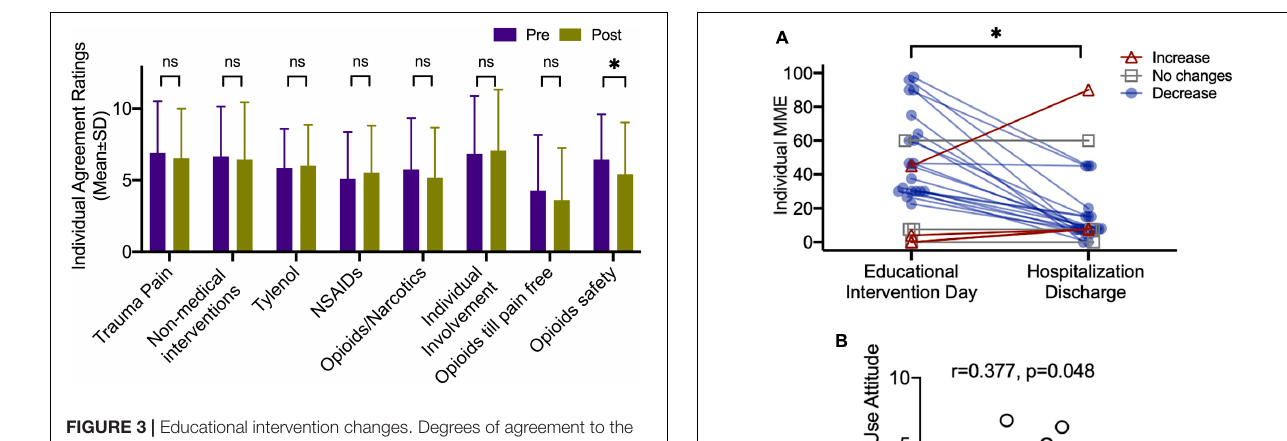
FIGURE 3 | Educational intervention changes. Degrees of agreement to the statements regarding the importance of pharmacological and non-pharmacological treatments for acute trauma pain. Opioids safety significantly changed with a decreased mean score of 6.92 (SEM = 0.60) at the pre-education phase as compared with 6.09 (SEM = 0.72) at the post-educational intervention ( F 1 , 24 = 9.08, p = 0.006) controlling for age, sex, and race. ∗ Indicate statistical significance.